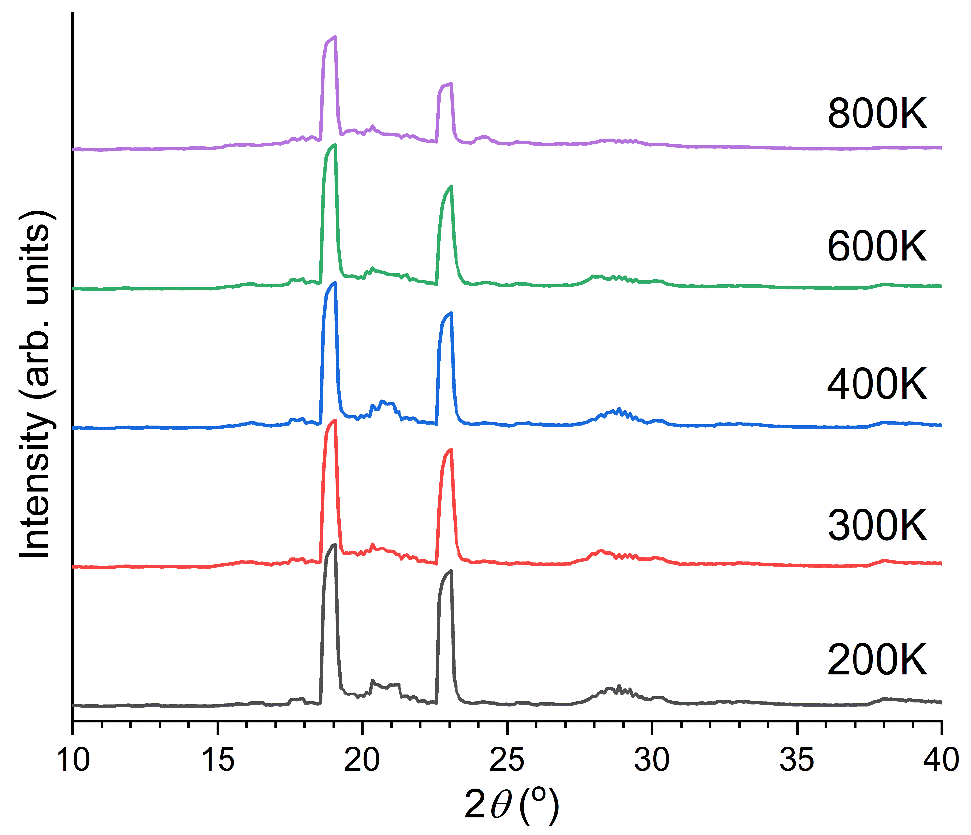
Figure 9. WAXRD patterns simulated using LAMMPS for a PEEK oligomer supercell corresponding to 9 × 9 × 5 unit cells.